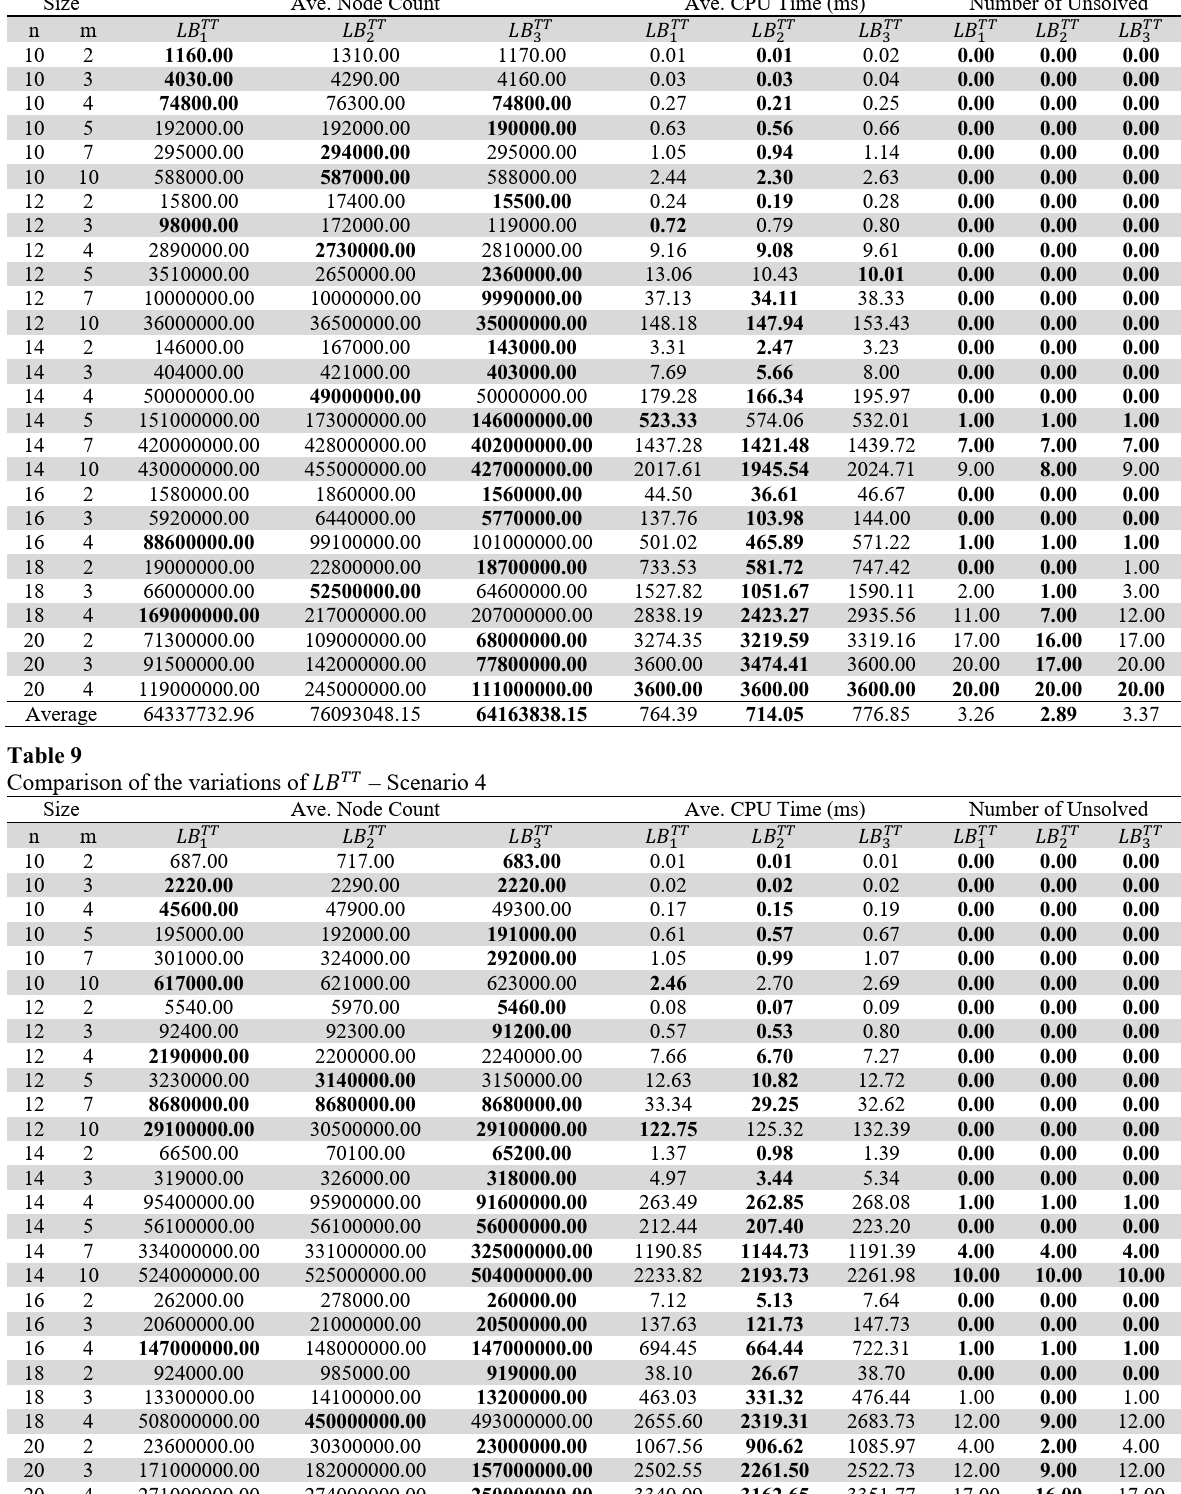
Comparison of the variations of 𝐿𝐵 (cid:3021)(cid:3021) – Scenario 3 Size